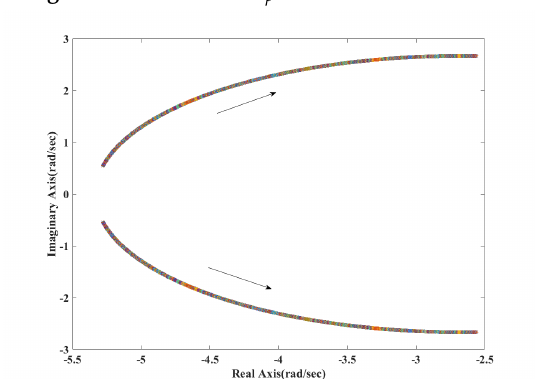
Figure 10. K p = 6 and m increases from 0.1 to 100.